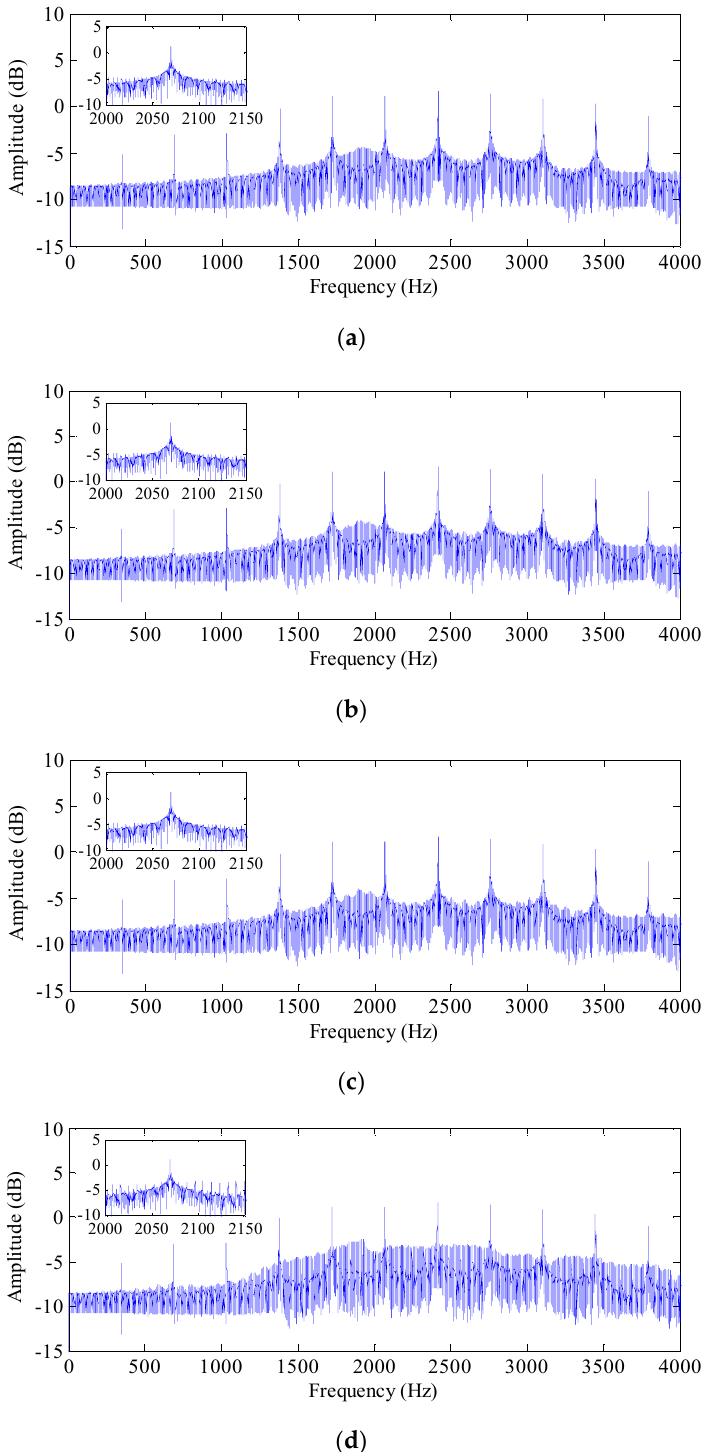
Figure 15. Acceleration spectra of different fault cases: ( a ) case #1, ( b ) case #2, ( c ) case #3, ( d ) case #4. From the above results, we can find that sidebands of the spectra resulting from the crack propagation are more sensitive than the time domain responses. Thus, the sideband amplitude ratio (BAR) is introduced to further quantitatively analyze the effects of the tooth surface crack propagation on the spectra of DTE and acceleration. The calculation formula of the BAR is as follows [35],